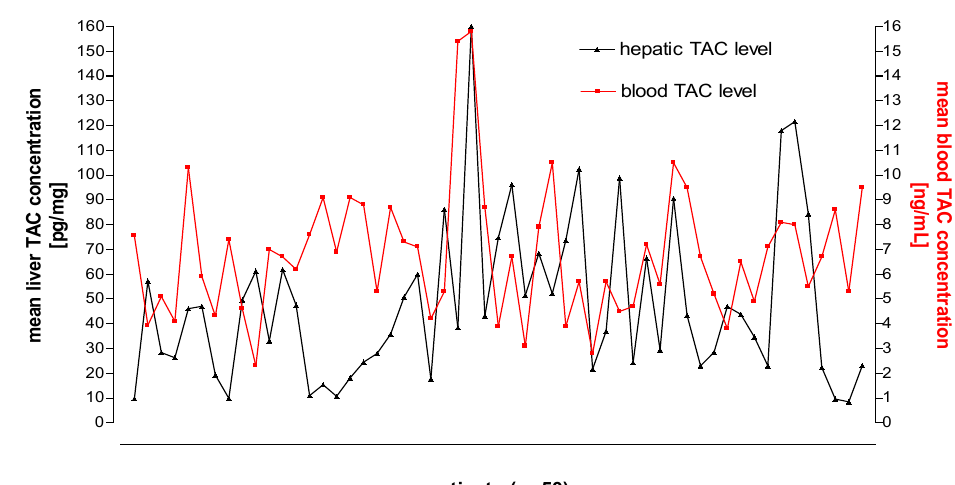
Figure 3. Kidney tissue and blood TAC levels determined in 50 transplant patients.